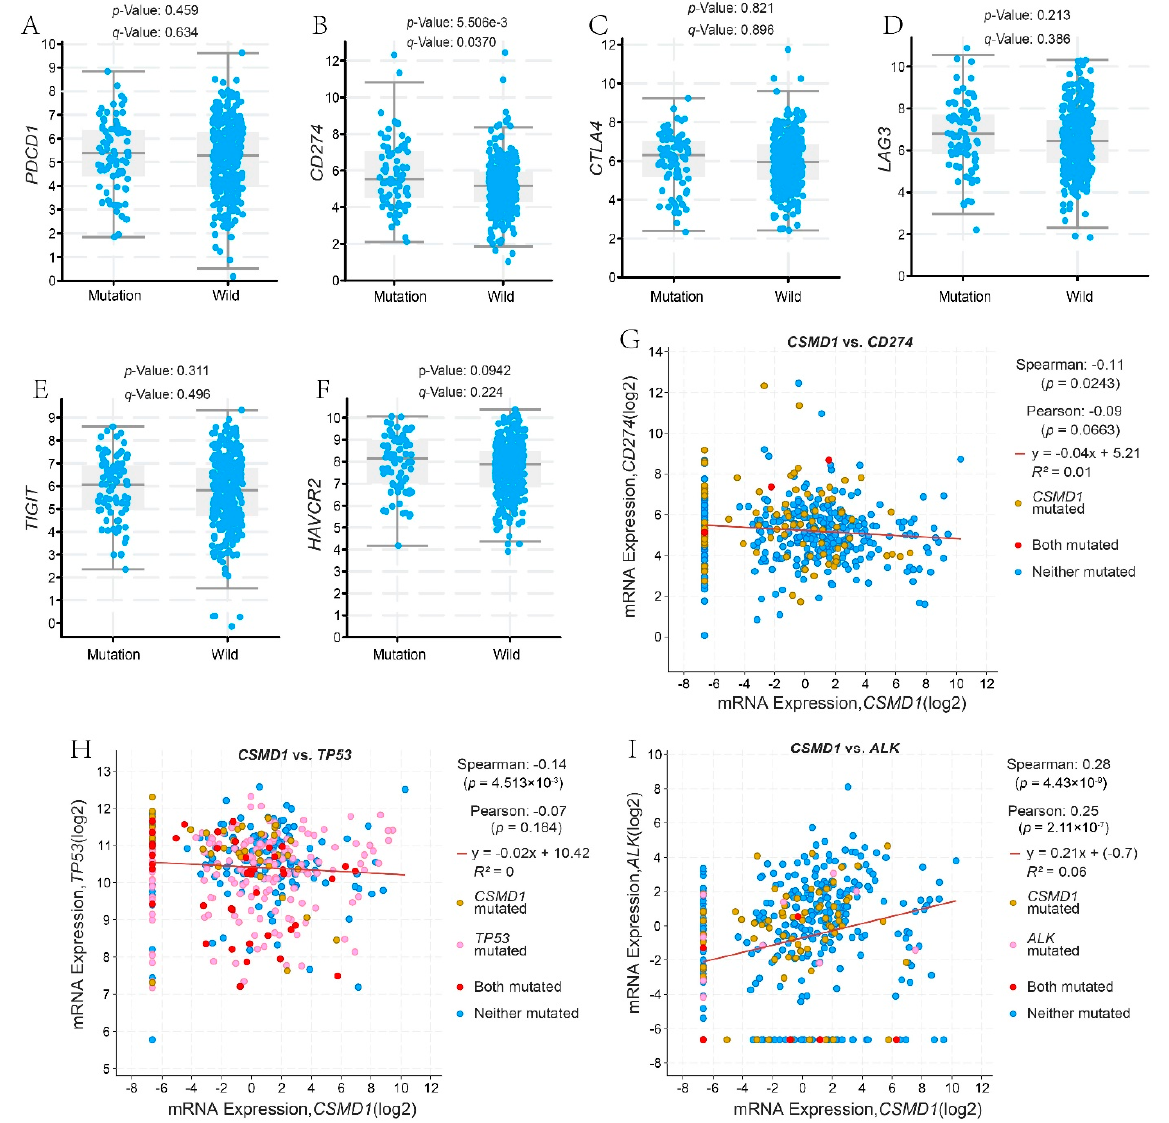
Figure 6. Correlation between expression of immune checkpoint molecules and CSMD1 -mut; ( A ) PD-1 ( PDCD1 ), ( B ) PD-L1 ( CD274 ), ( C ) CTLA4 , ( D ) LAG3 , ( E ) TIGIT and ( F ) TIM3 ( HAVCR2 ). ( G ) Co-expression of CSMD1 and PD-L1 ( PDCD1 ). Correlation between the expression of genes involved in related signaling pathways and CSMD1 -mut; ( H ) TP53 and ( I ) ALK . The figures were from cBioportal